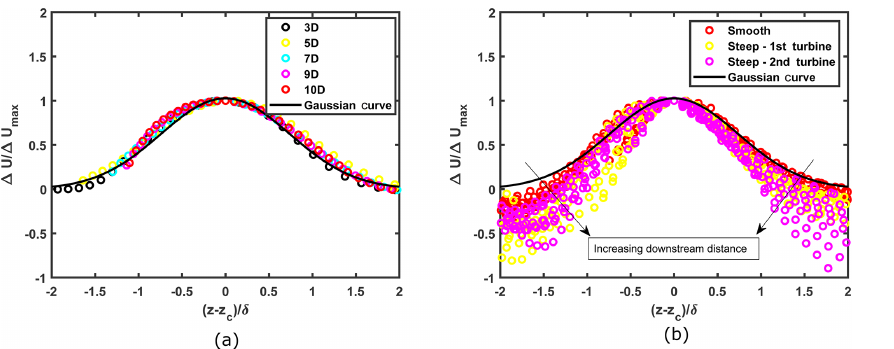
Figure 16. Self-similar vertical velocity deficit profiles (a) flat case (b) complex cases for a downstream distance of 1D to 5D with intervals of 0.5D. Arrows indicate direction of increasing downstream